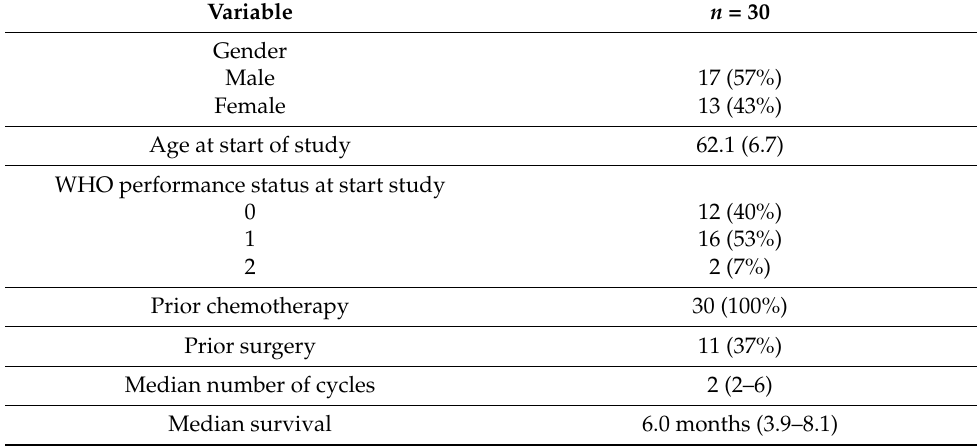
Table 3. Patient characteristics phase I and II combined for the patients of phase I that received prior treatment with FOLFIRINOX and treatment LDE225 200